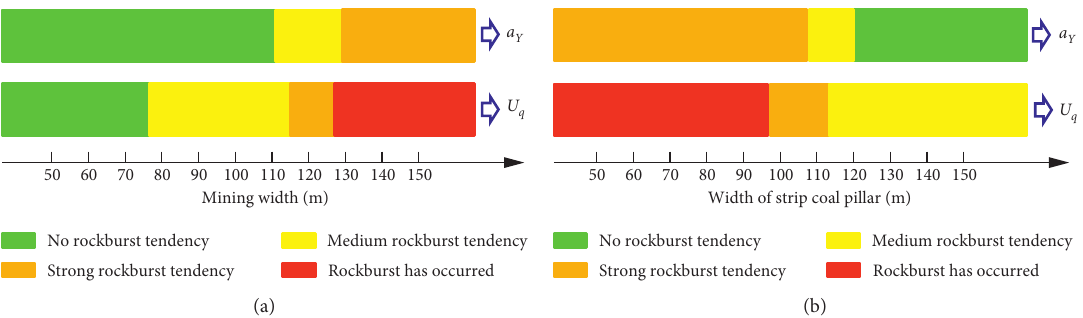
Figure 9: Rockburst risk under different mining widths and the width of strip coal pillar: (a) width of strip coal pillar is fixed as 120m; (b) mining width is fixed as 120m.